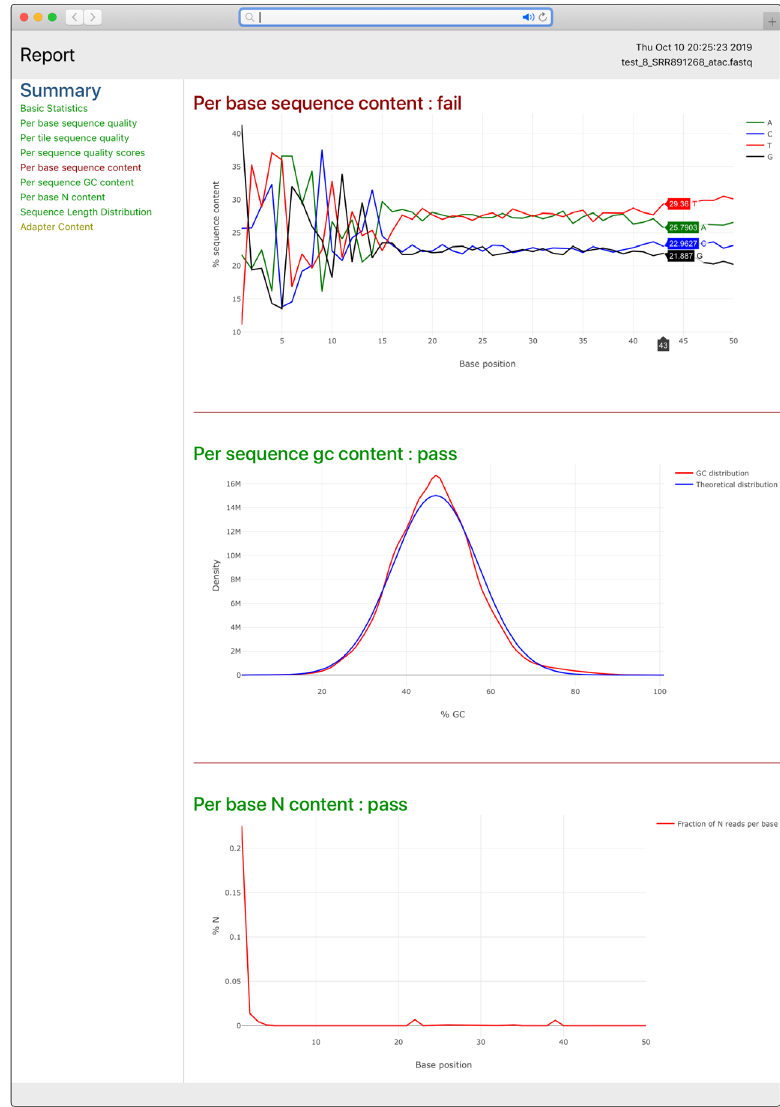
Figure 1. Sample HTML report for test 8 (accession SRR891268). Layout and plots are based on FastQC ’s HTML